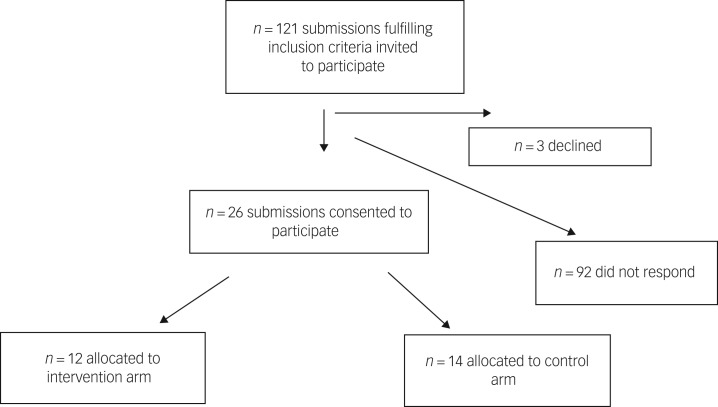
Participant flow.